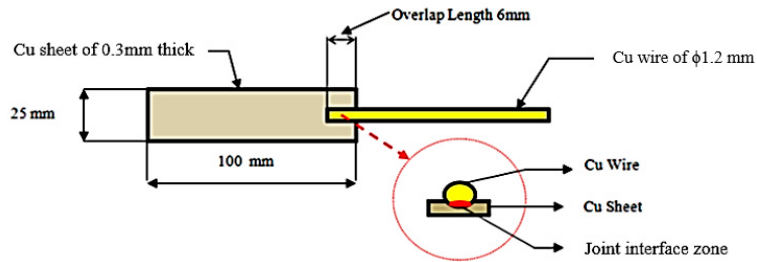
Figure 1. Schematic representation of the joint.